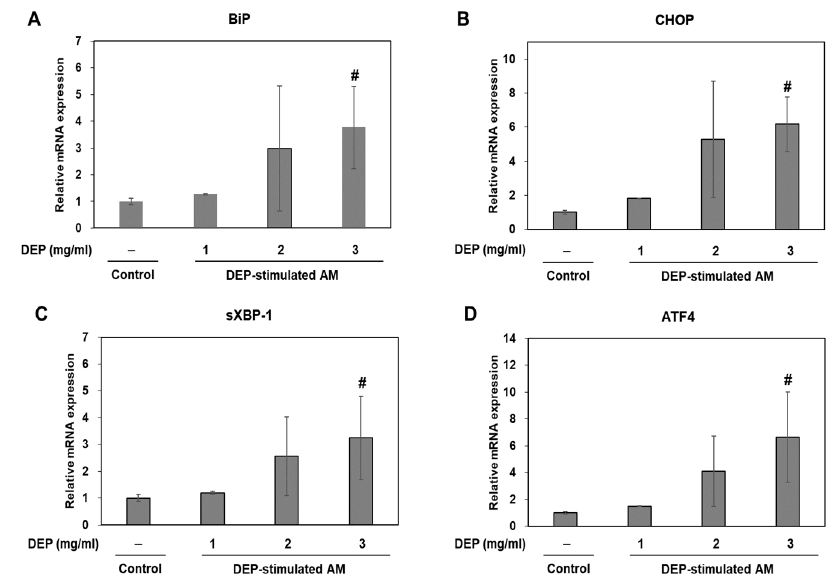
Figure 4. ER stress-related gene expression levels. ( A ) BiP, ( B ) CHOP, ( C ) sXBP-1, and ( D ) ATF4 in DEP-stimulated AM. AM were stimulated DEP 1, 2, or 3 mg mL − 1 with. RT-qPCR was performed 3 h after DEP stimulation. Data are means ± SD ( n = 3 per group). # p < 0.05 vs. control.